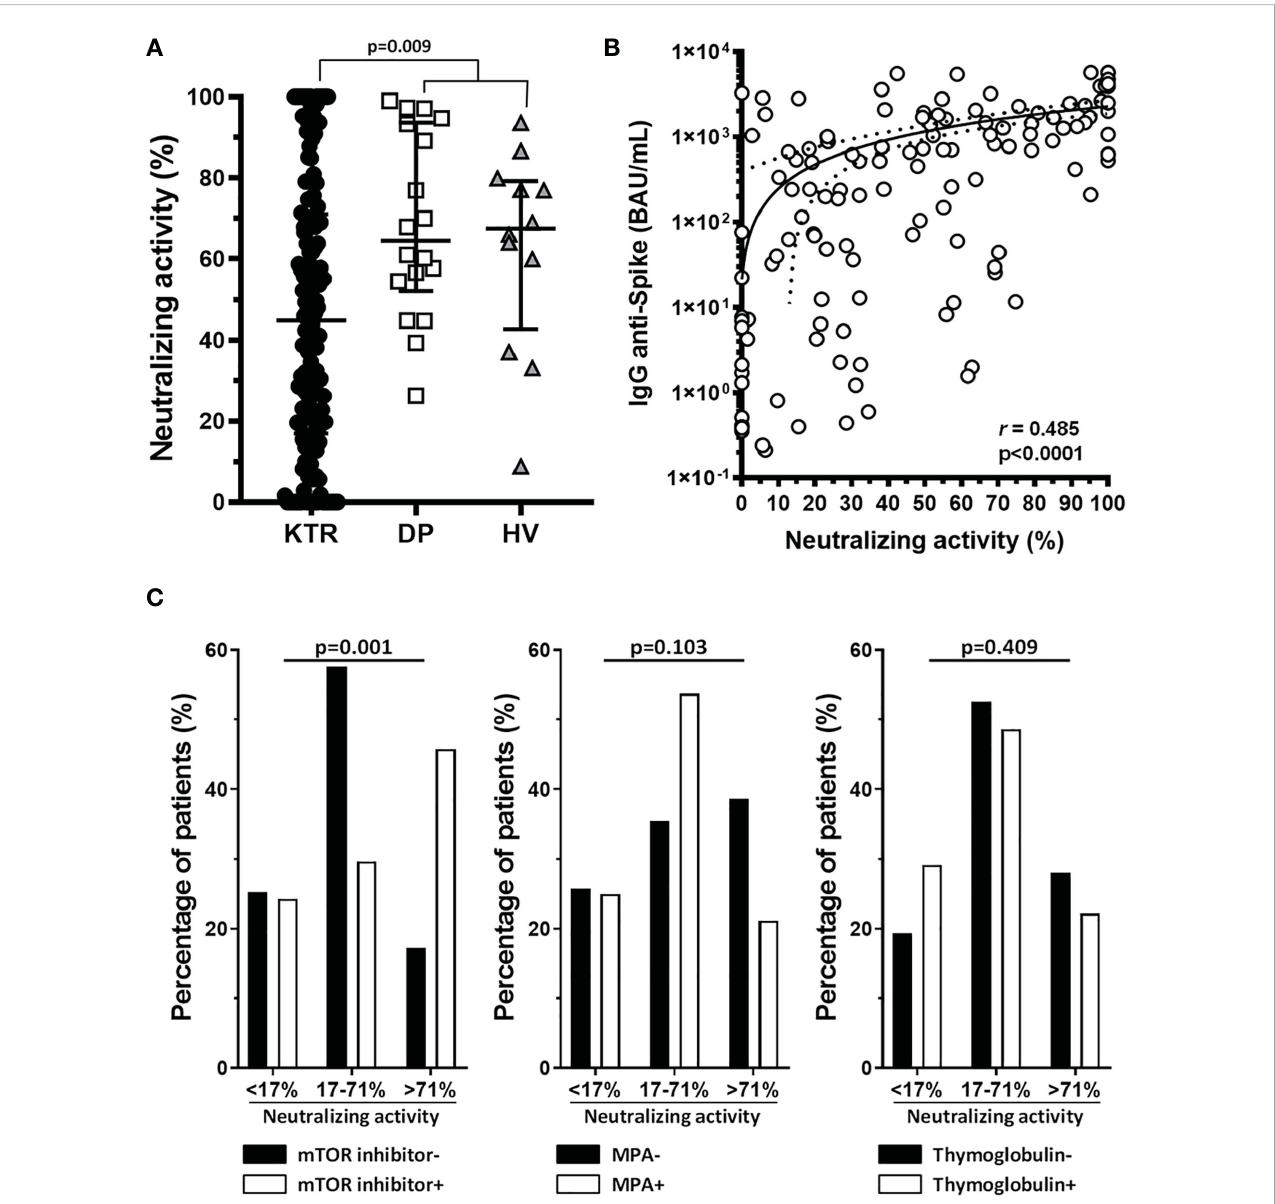
FIGURE 5 Sera from renal transplant recipient patients show lower RBD-ACE2 binding neutralizing activity than control groups, which correlates with antibody levels, and mTOR inhibitors treatment enhance neutralizing activity of sera of these patients. (A) Graph shows the neutralizing activity of patient sera at 1:25 dilution in patients (KTR) and control groups (DP and HV), with median and IQR, and p-value for Mann-Whitney U test. (B) Graph shows the correlation of neutralizing activity with antibody levels calculated with Spearman ’ s Rho. (C) Graphs show the percentage of patients with a range of neutralizing activity (divided in three percentiles, according to p25 and p75, <17%, 17%-<71% and >71%) for mTOR inhibitor, MMF and thymoglobulin treatment after the third dose of